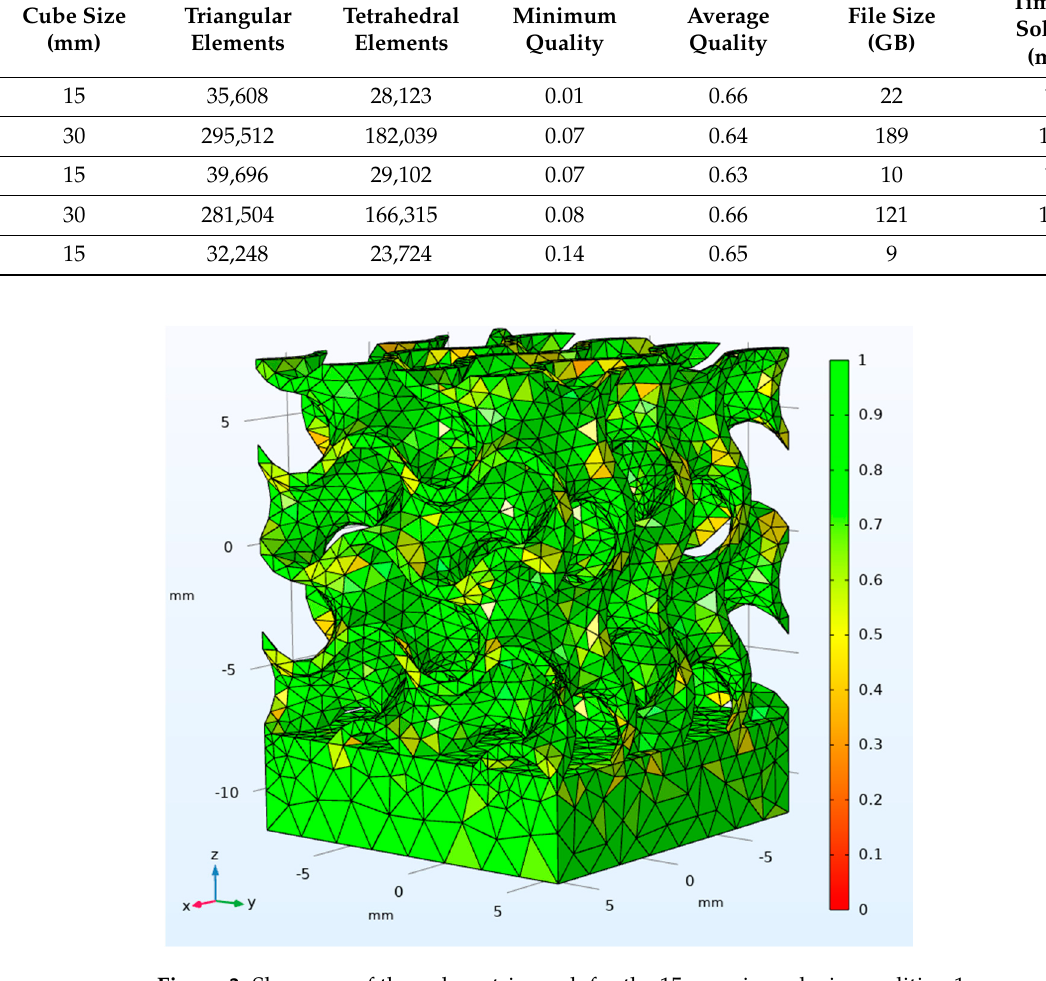
Figure 3. Skewness of the volumetric mesh for the 15 mm size cube in condition 1. Table 3. Surface and volumetric mesh description, with resulting quality, file size and time for solving. Cond .